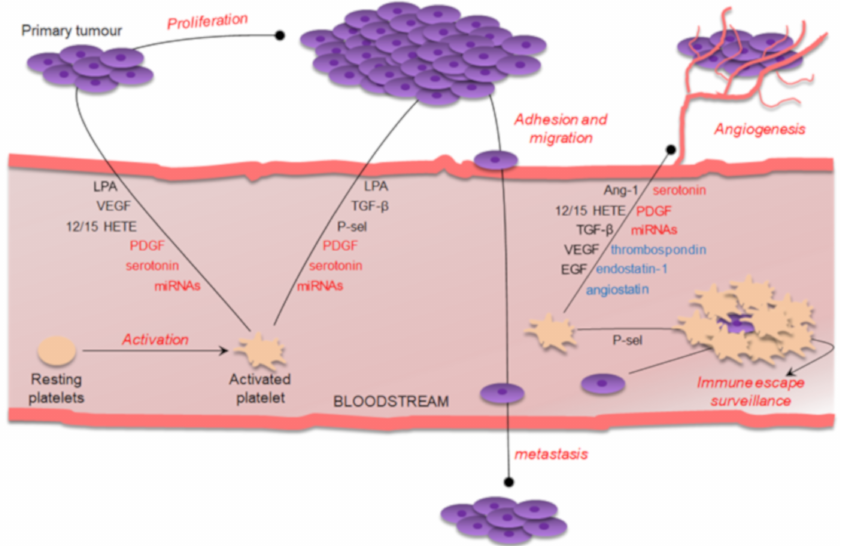
Figure 1. Schematic representation of the main platelet e ff ects on tumor biology. See text for details. In black: platelet-derived bioactive molecules with positive e ff ects. In blue: platelet-derived compounds with negative e ff ects. In red: platelet-derived compounds with both positive and negative e ff ects. Lines with dot indicate either stimulation or inhibition, depending on the platelet-derived bioactive